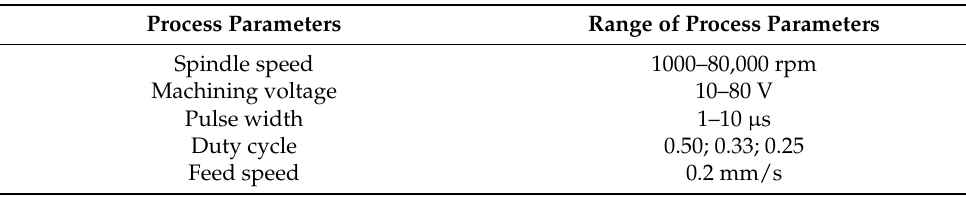
Table 2. Main process parameters used in the paper.